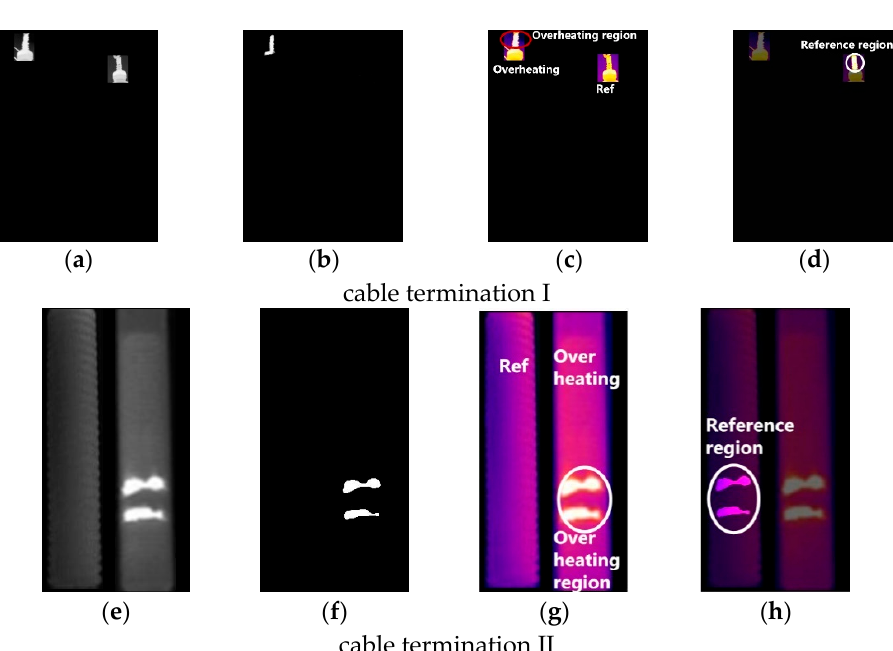
Figure 13. Location results of reference regions of cable terminations: ( a ) & (e) grayscale image, ( b ) & (f) extracting results of suspected abnormal heating regions, ( c ) & (g) suspected abnormal heating phase and reference phases, ( d ) & (h) locating results of reference regions.